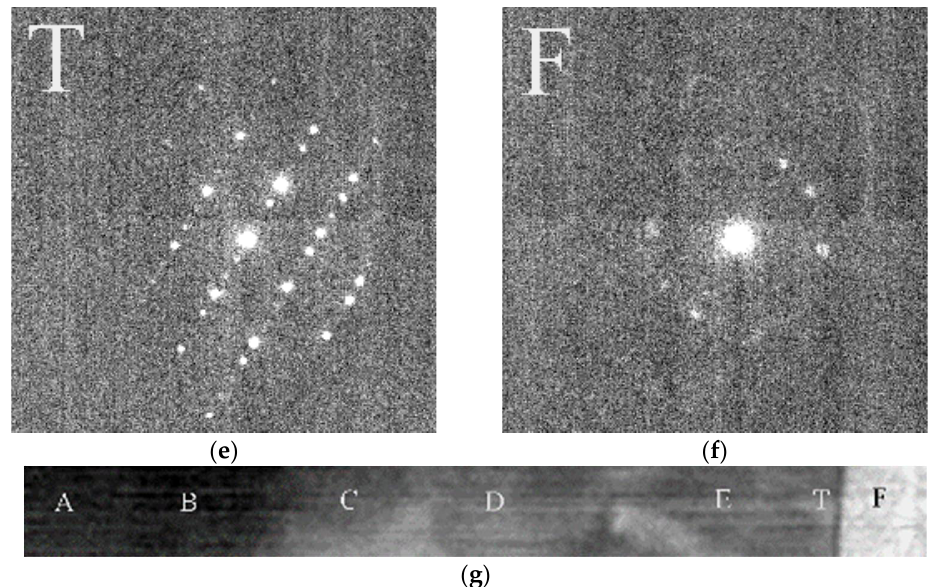
Figure 2. Illustration of how different diffraction patterns can be measured within a 400 nm wide region of a Si sample. Locations are marked on ( g ). ( a ) The pattern recorded at location A. Three diffraction spots are marked with numerals (0 is the central spot, 1 and 2 mark the endpoints of the two shortest reciprocal lattice vectors) ( b ) The pattern recorded at location B. Three diffraction spots are marked with characters (0 is the central spot, N and L mark normal and lateral directions from the central beam) ( c ) The pattern recorded at location C. ( d ) The pattern recorded at location D. ( e ) The pattern recorded at location T, which is a position of nanotwins. ( f ) The pattern recorded at location F, which is the position of C-Pt protecting layer deposited during FIB preparation. ( g ) STEM HAADF image of the 400 nm wide region. Letters mark the locations where the diffraction patterns were collected.